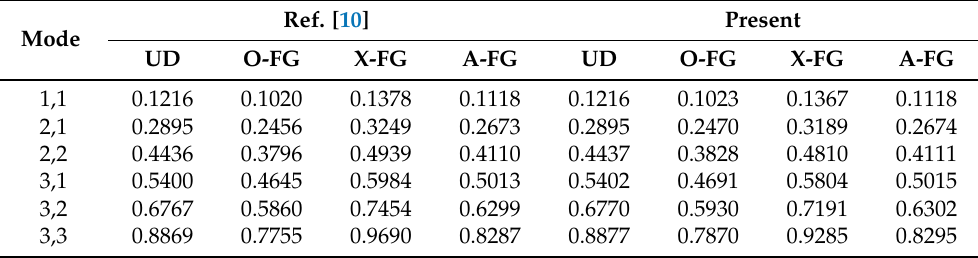
Table 2. Comparison of nondimensional natural frequencies ˆ ω = ω h plates for various GPLs distribution patterns ( E m = 3 GPa, ν m = 0.34, ρ m = 1200 kg/m 3 , W G = 0.01, N = 10).